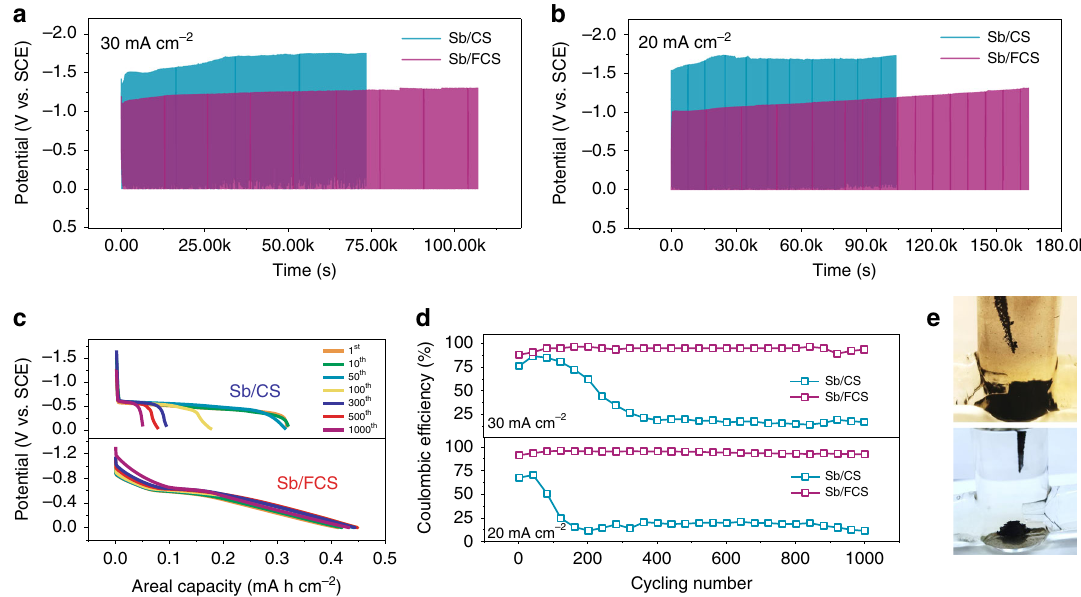
Fig. 2 Electrochemical characterizations of Sb/CS and Sb/FCS electrodes. Voltage pro fi les of Sb/CS and Sb/FCS with a fi xed charging capacity of 0.47mAh cm − 2 at a 30mAcm − 2 (55s charging) and b 20mAcm − 2 (85s charging). c Corresponding discharging curves at different cycles at 20mAcm − 2 and d CE of the Sb stripping/plating on the bare CS and FCS. e Optical photographs of Sb/CS and Sb/FCS after 1000 cycles at 20mAcm − 2